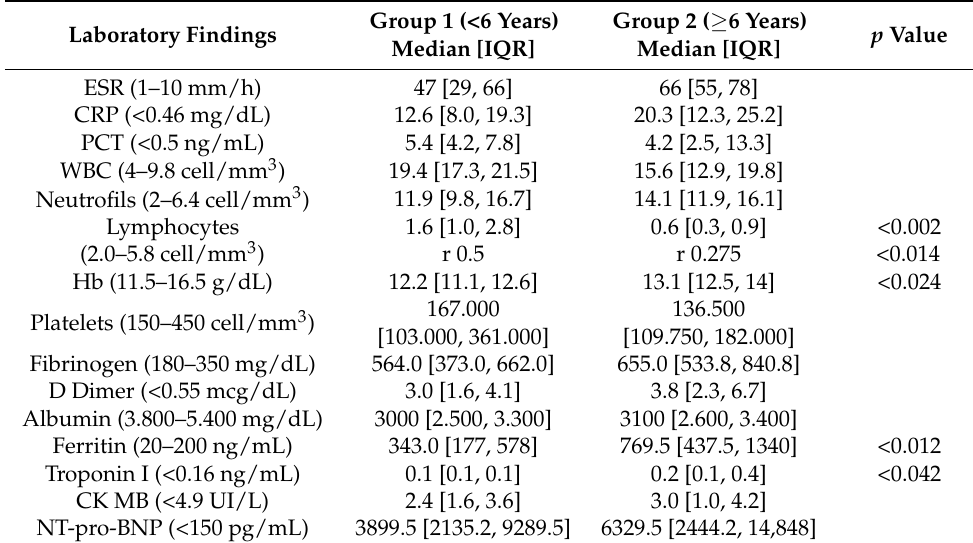
IQR: interquartile range; y: years; ESR: erythrocyte sedimentation rate; CRP: C-reactive protein; PCT: procalci- tonin; WBC: white blood cells; r: ratio; Hb: hemoglobin; CK-MB: creatine-kinase MB; NT-pro-BNP: N-Terminal prohormone of brain natriuretic